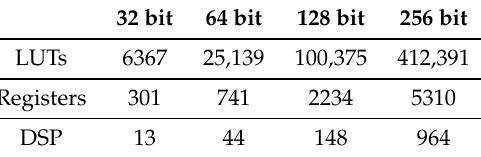
Table 4. RSA implementation size by each bit.